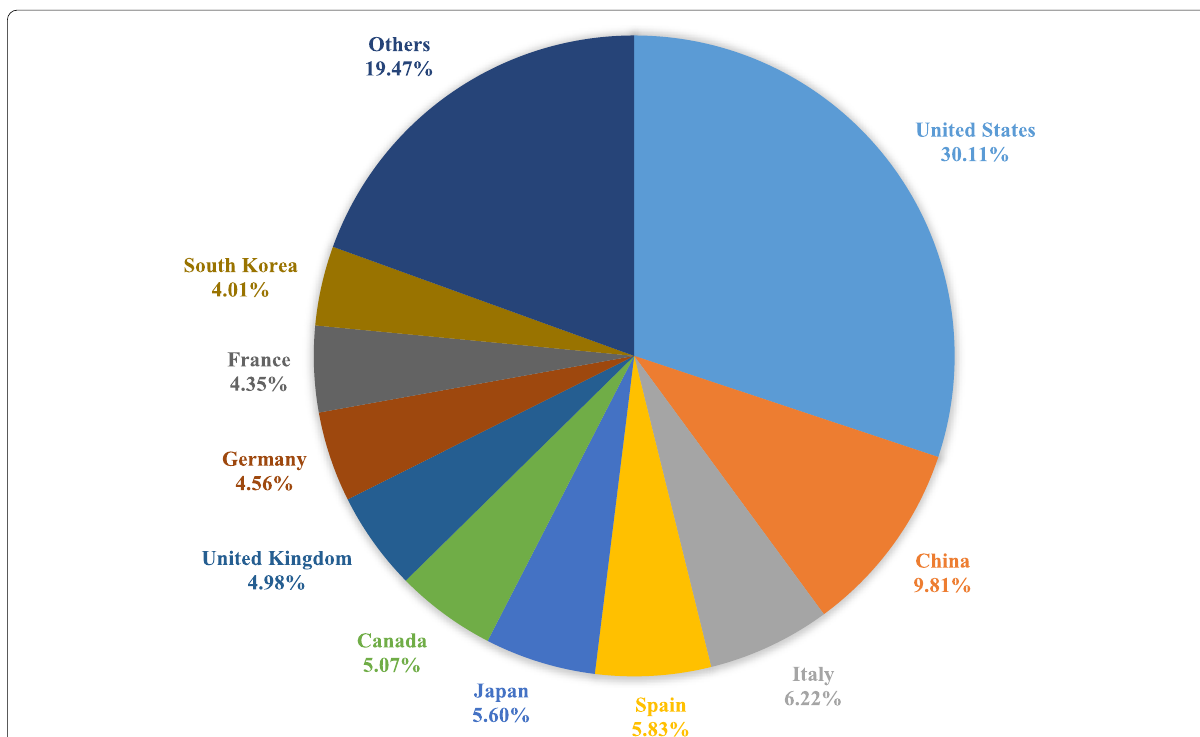
Fig. 3 Distribution of the top ten countries that published research on insulin resistance and obesity from 2002 to 2021